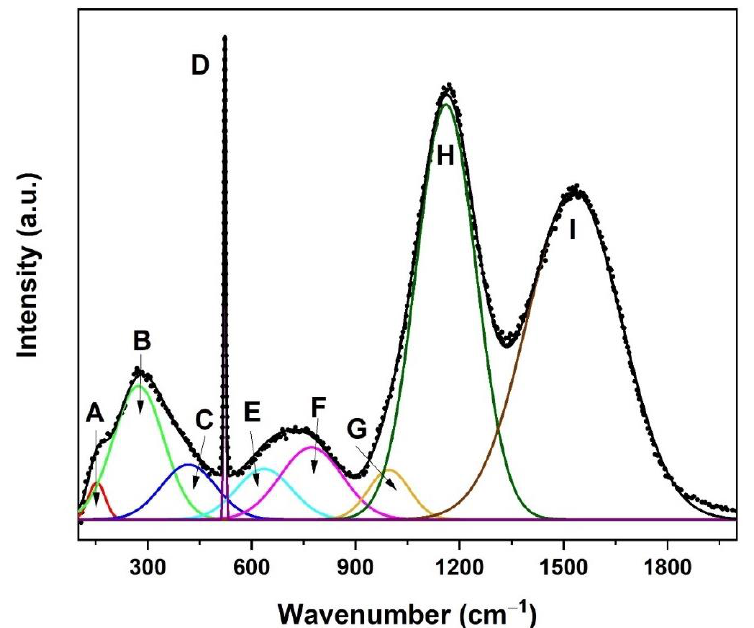
Figure 7. Deconvolution of Raman spectra of sample B570 in various Gaussian bands. The bands investigated in this work labelled as A – I are marked.